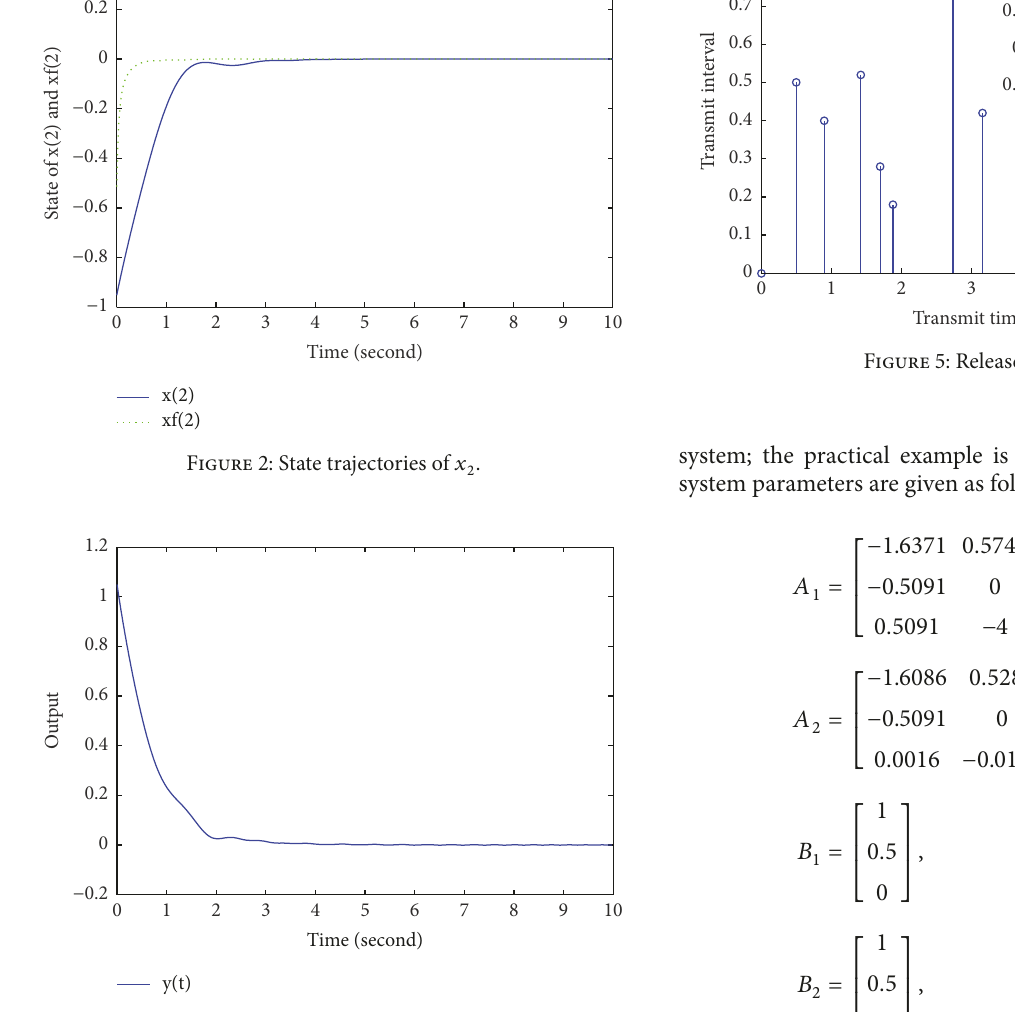
Figure 3: The trajectories of 𝑦(𝑡) .